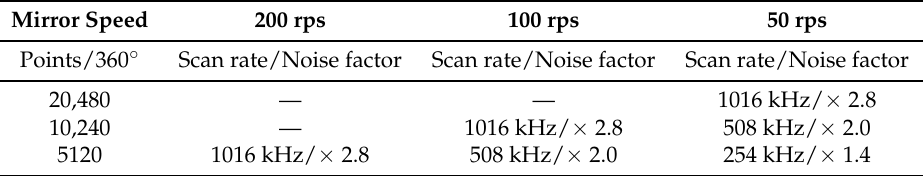
Table 1. Different settings of the Z + F Profiler 9012A (mirror speed, number of points per scanning profile) along with the factors for converting the noise specifications for the standard scan rate of 127 kHz (Table 2) to the actual scan rates of 254 kHz, 508 kHz or 1016 kHz (according to [27]). Mirror Speed 200